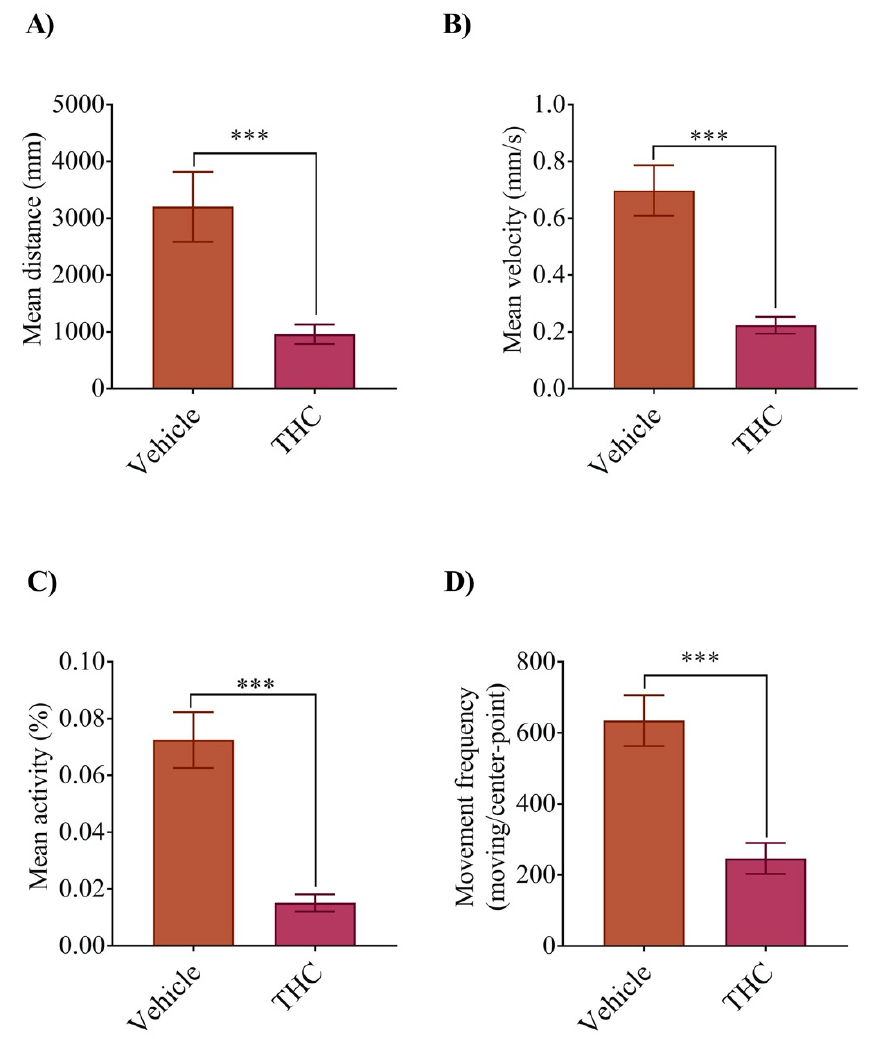
Figure 6. THC exposure affects free swimming activity (locomotion) of zebrafish embryos at 5 dpf. Bar graphs display changes in larval mean distance moved ( A ), mean velocity (in mm/s for one hour) ( B ), mean activity (% rate for one hour) ( C ), and frequency of swim bouts within one hour ( D ). *** significantly different from vehicle control, p < 0.001.